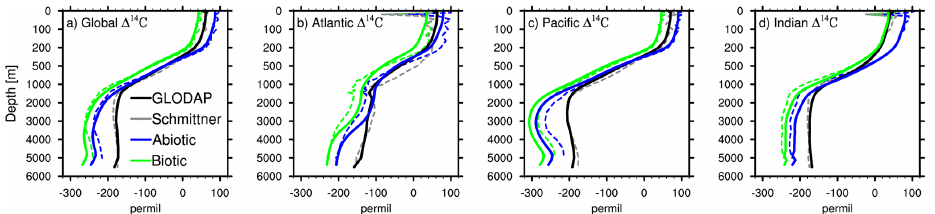
Figure 4. Depth profiles of (cid:49) 14 C for (a) the global ocean, (b) the Atlantic Ocean, (c) the Pacific Ocean, and (d) the Indian Ocean. The simulated biotic (green) and abiotic (blue) (cid:49) 14 C is compared to the global gridded GLODAP (cid:49) 14 C (black) data set (Key et al., 2004). In addition, dashed lines show the cruise data compiled by Schmittner et al. (2013) (gray) and the model-simulated data subsampled at the same locations as these data (green and blue dashed